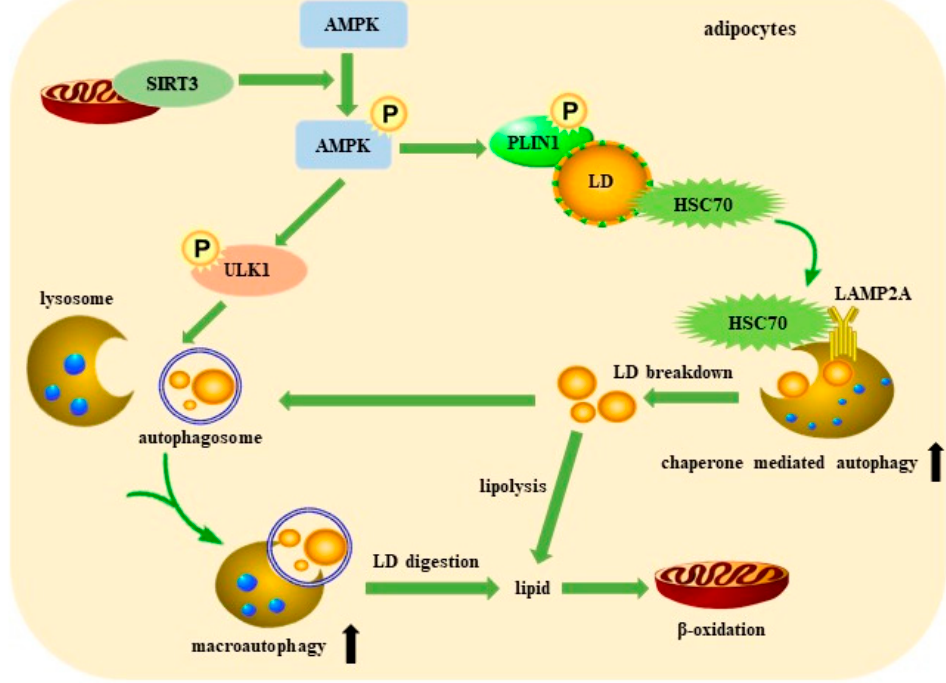
Figure 7. Schematic diagram of the role of SIRT3 in promoting lipid mobilization in adipocytes. Supplementary Materials: Supplementary materials can be found at www.mdpi.com/xxx/s1.